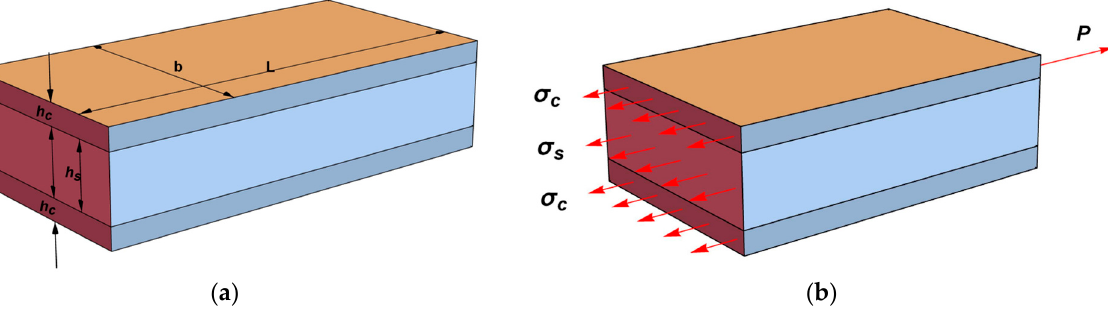
Figure 1. ( a ) Sketch of the sample consisting of a substrate of thickness h s and two surface carbonized layers, each with thickness h c . ( b ) Part of the sample in equilibrium under the action of stresses ( σ s and σ c ) and external force (P).